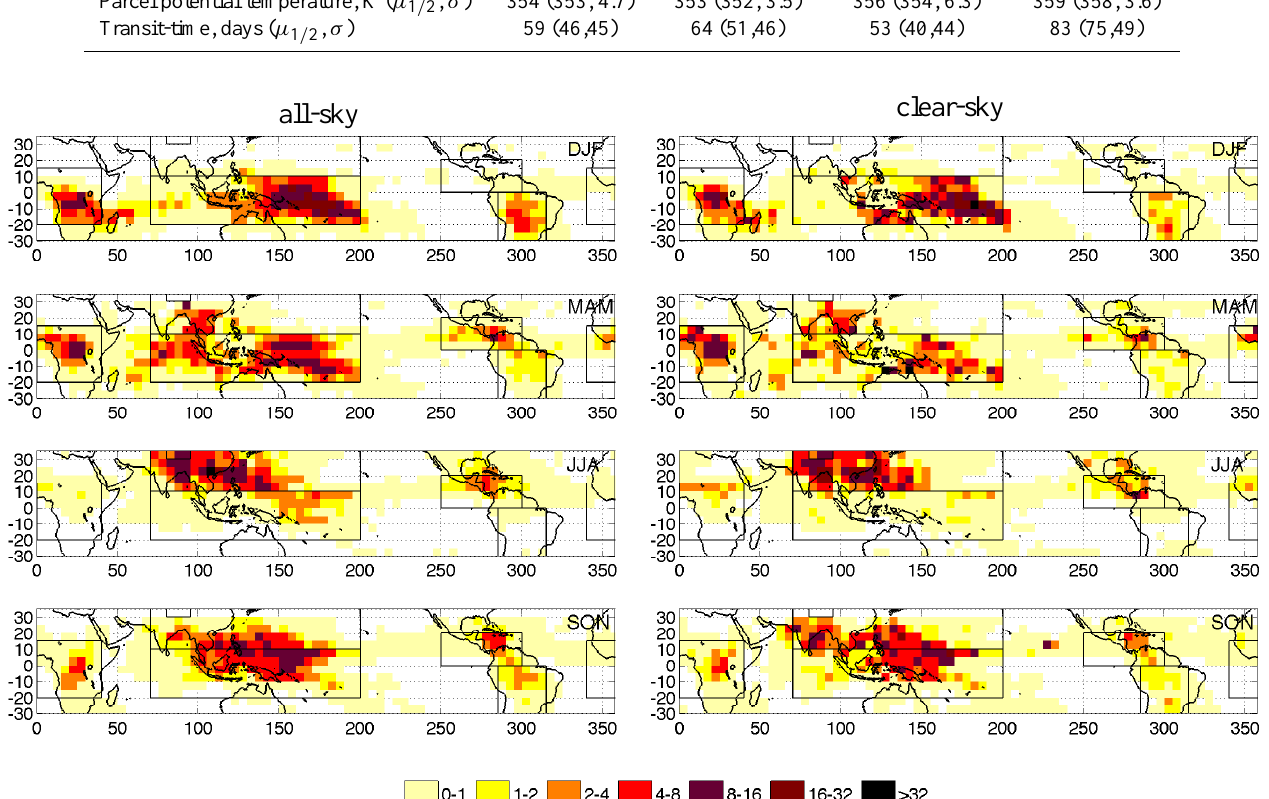
Fig. 4. Seasonal variations of the distribution ρ 100hPa of the horizontal locations where trajectories, initially launched at 100hPa, have intersected clouds within the previous 200 days for the boreal winter (DJF), spring (MAM), summer (JJA), and fall (SON) seasons in 2005. The distributions on the left panels are calculated under all-sky conditions from the ALLSKY- 1T 0 trajectory ensemble, while those on the right panels are calculated under clear-sky conditions, using the CLRSKY- 1T 0 ensemble. The distributions are binned in a 5 ◦ × 5 ◦ longitude/latitude grid. The solid boxes define a set of geographical regions which are (from left to right): Af, NAP, NAPL, Tib, SAP, CAm and SAm as defined in Fig.